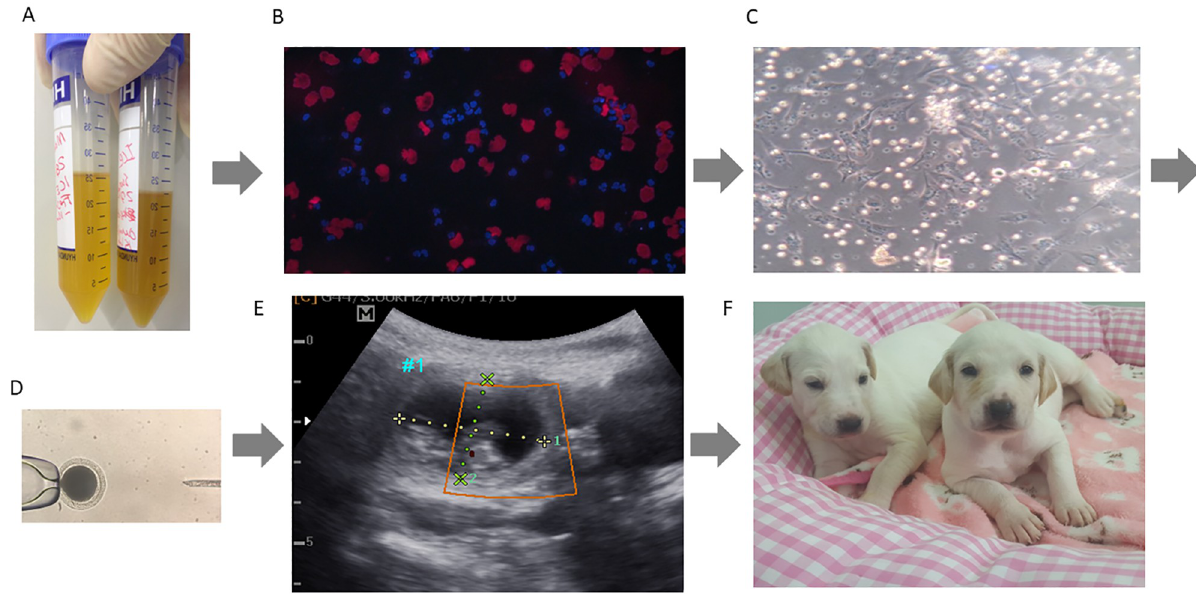
Fig 5. The UDC cloning flow through. A) Urine collected, B) Analysis of cellular viability, C) UDCs established D) SCNT performed, E) Ultrasonic pregnancy confirmation at ~30 days after embryo transfer, F) Cloned puppies.